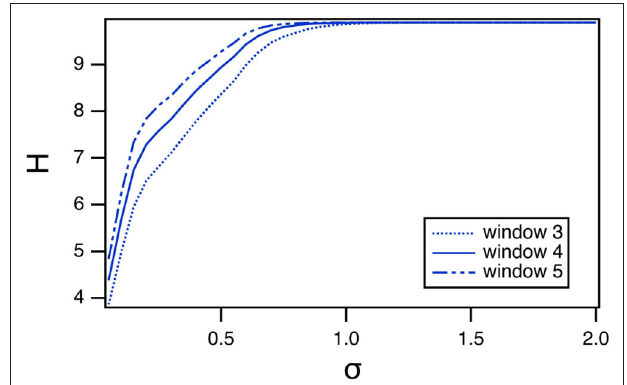
FIGURE 12 | Nearest neighbor entropy H nn as a function of the spectral radius σ for the polynomial ODE reservoir computer driven by Sprott systems A,B,C, and D, as the window length varies. For this plot, p 1 = − 0.5 and the time constant T 0 = 0.3.